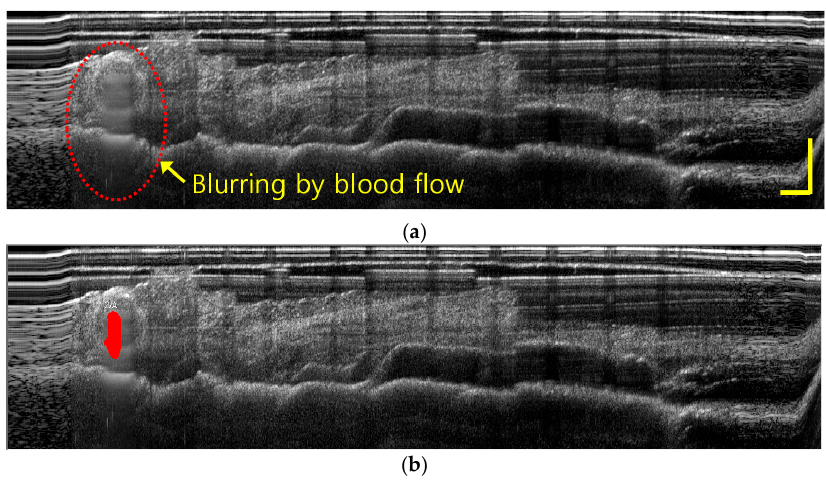
Figure 7. ( a ) In vivo imaging of the blood flow inside the fatty tissue of a porcine model with IGLaST. ( b ) Identification of blood flow with the morphological image processing technique.